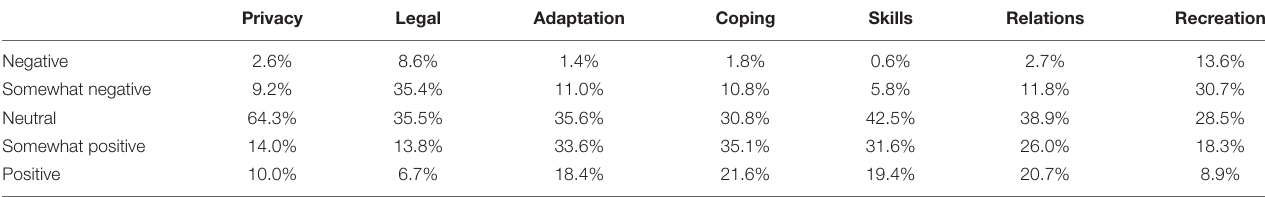
TABLE 3 | Anticipated positive vs. negative outcomes distributions.